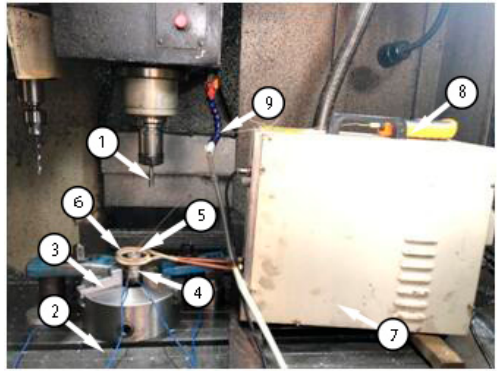
Figure 2. Experimental apparatus for the forming process. 1—Extrusion tap; 2—Worktable; 3—Special fixture; 4—Torque sensor; 5—Temperature sensor; 6—Coil; 7—Induction heater; 8—Thermometer; 9—Cooling water pipe.